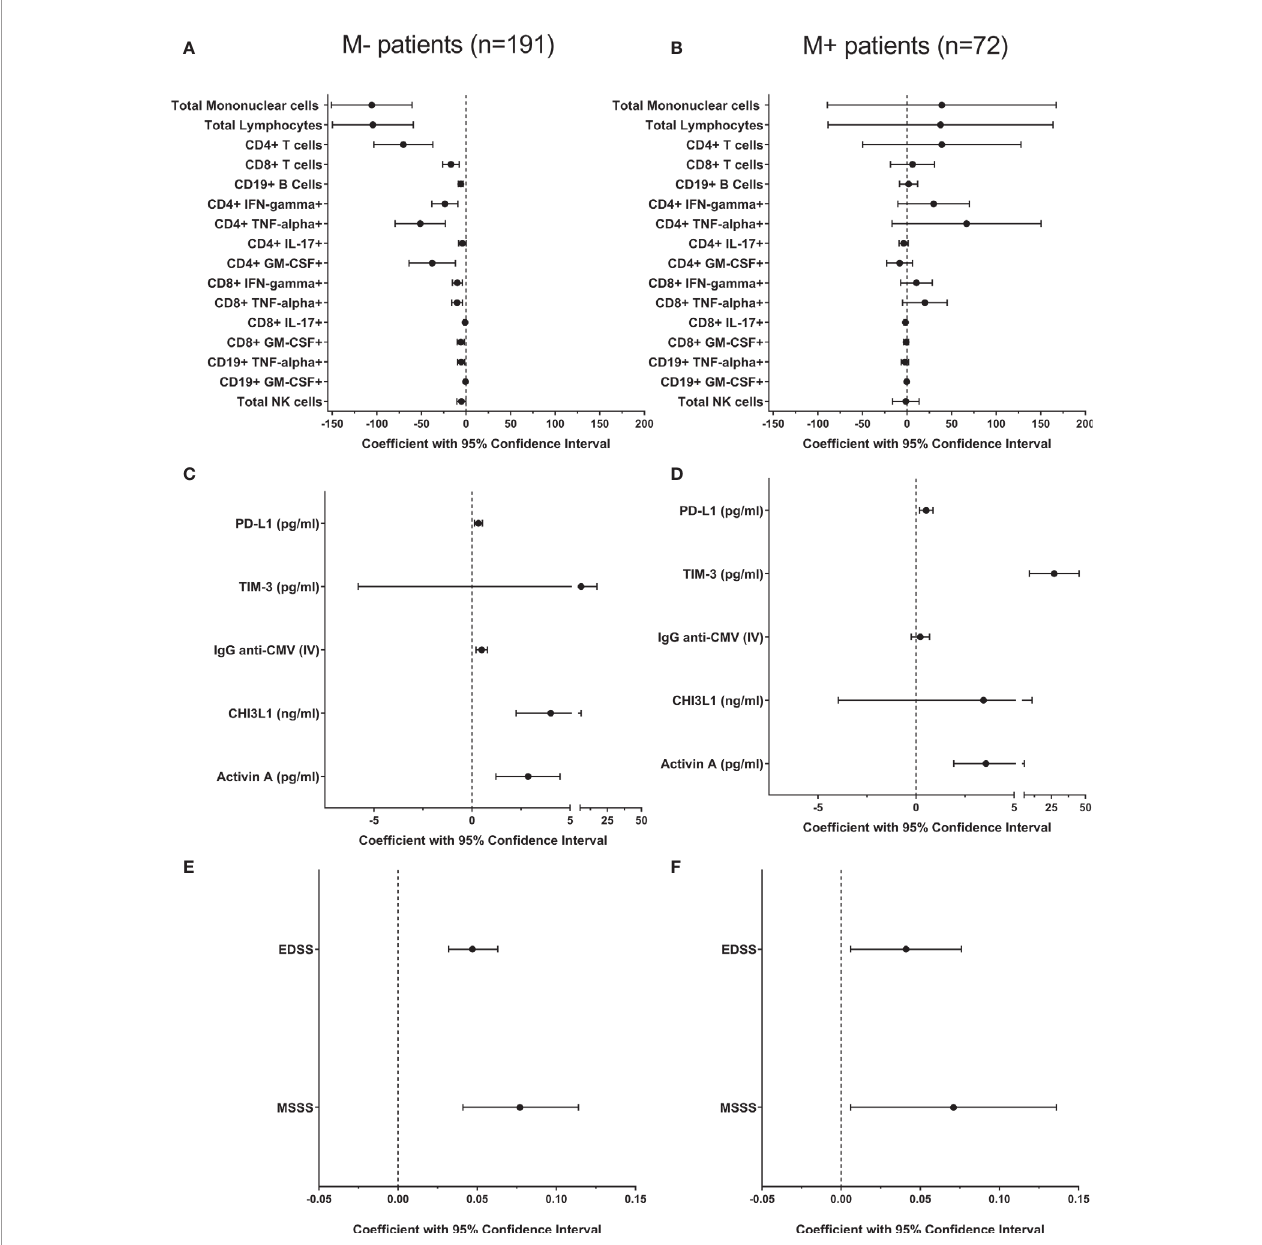
FIGURE 1 | Multivariate regression analysis to explore the effect of age on immune response and disability in M- and M+ patients. We explored in fl uence of age in different leukocyte subsets [ (A, B) cells/ml] and in soluble factors levels (C, D) related to adaptive and innate immune responses in patients lacking [M-, n=191 (A, C) ] and showing [M+, n=72, B, (D) ] lipid-speci fi c oligoclonal IgM bands. All variables were quanti fi ed in CSF with the exception of IgG anti-CMV, quanti fi ed in serum. The effect of age on disability in M- (E) and M+ (F) patients was also studied. All coef fi cients (black circles) and 95% con fi dence intervals were adjusted by disease duration. CHI3L1, Chitinase 3-like 1; CMV, Cytomegalovirus; CSF, cerebrospinal fl uid; EDSS, Expanded Disability Status Scale; IFN, Interferon; IL, Interleukin; IV, Index Value; GM-CSF, Granulocyte/macrophage-colony stimulating factor; MSSS, MSSS, Multiple Sclerosis Severity Score. NK, Natural Killer; PD-L1, Programmed Death-ligand 1; TIM-3, T-cell immunoglobulin and mucin domain-3; TNF, Tumor necrosis